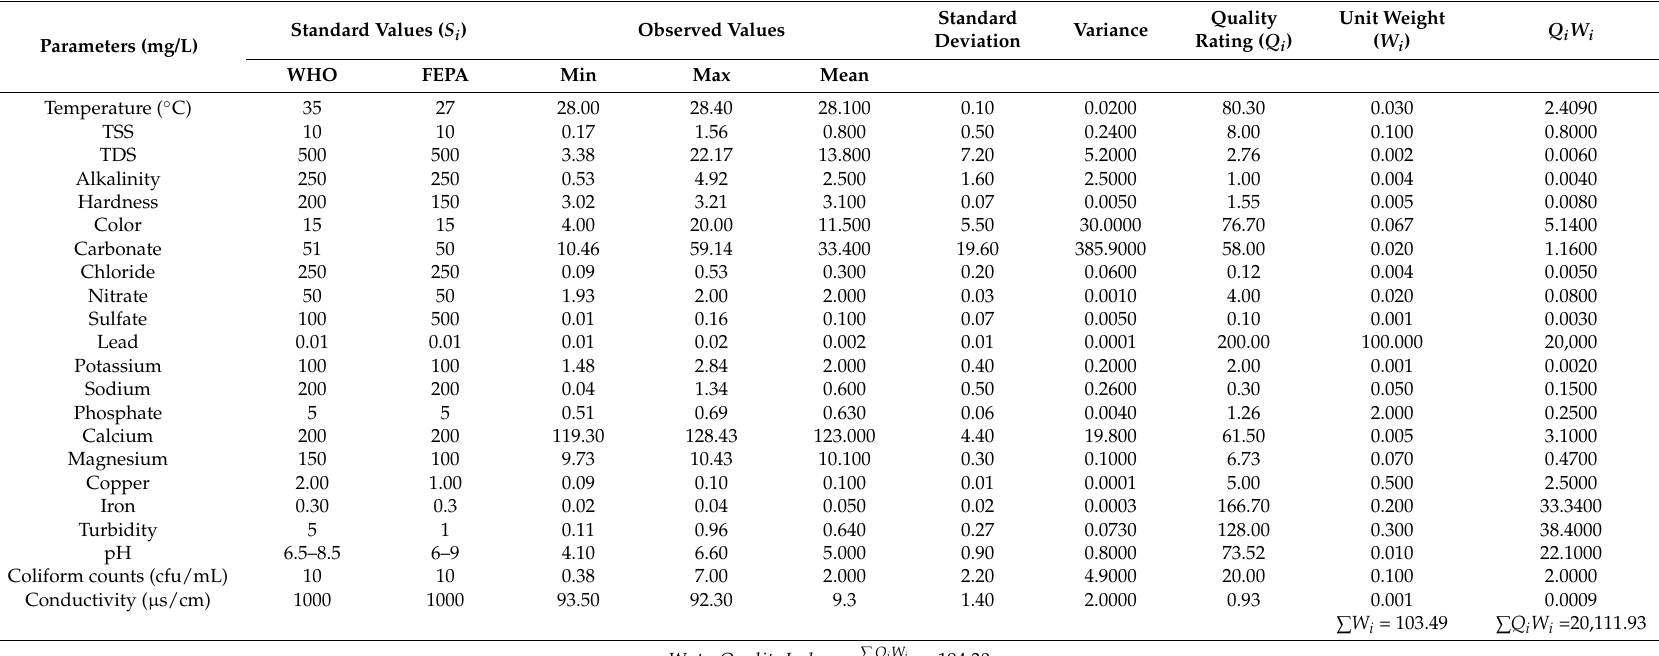
Table 6. Statistical summary of the hydrogeochemical analysis for boreholes in the study